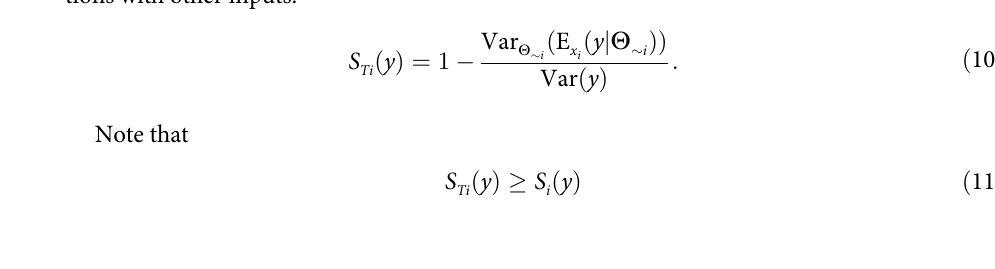
Death from hospital